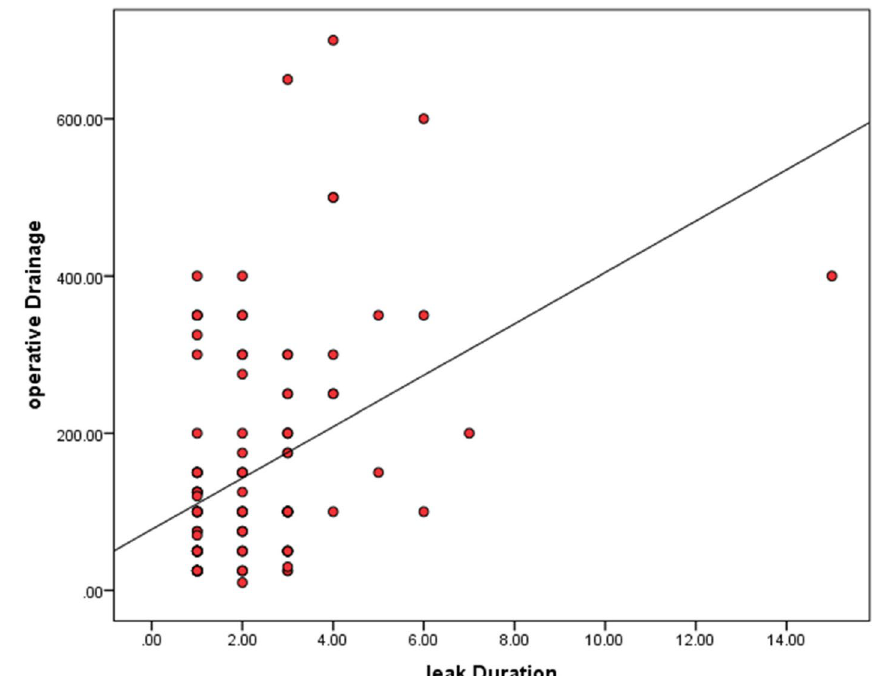
Fig. 4 Relationship among postoperative leak duration & operative